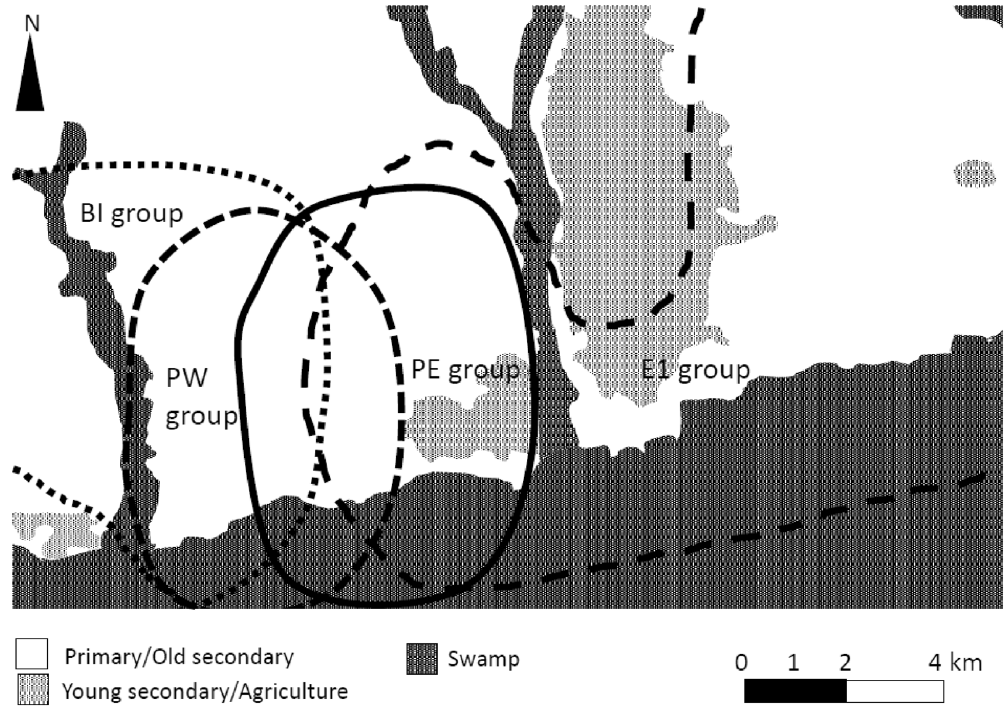
Figure 1. The approximate outlines of the four groups of bonobos that live in the Wamba area (PE, PW, BI and E1) 35